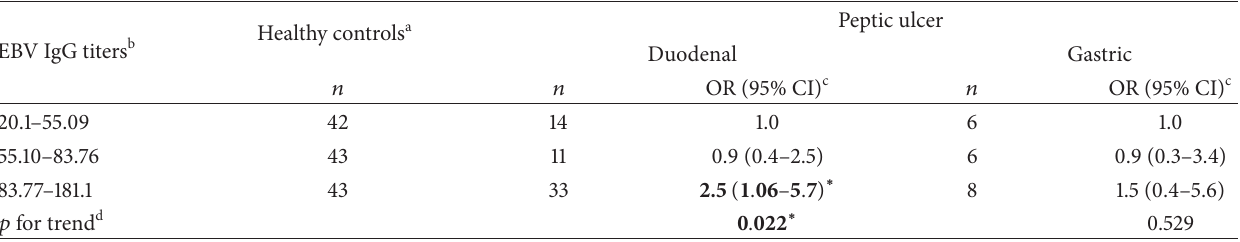
Table 2: Odds ratios and trends for EBV IgG antibody titers and peptic ulcer disease.